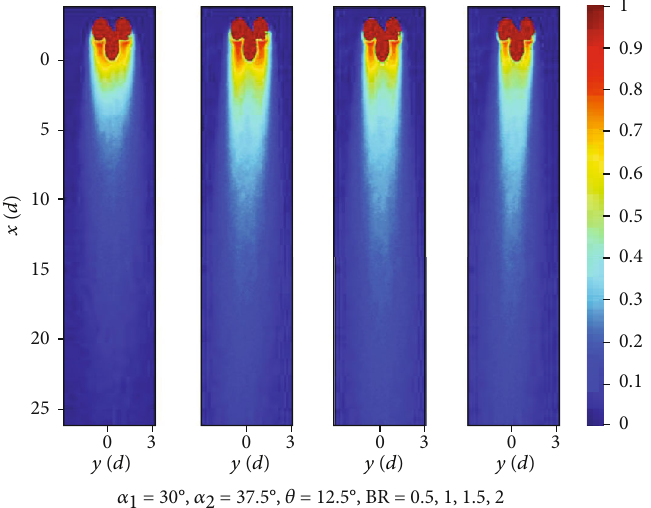
Figure 11: Film cooling e ff ectiveness distributions downstream of the branched holes, α